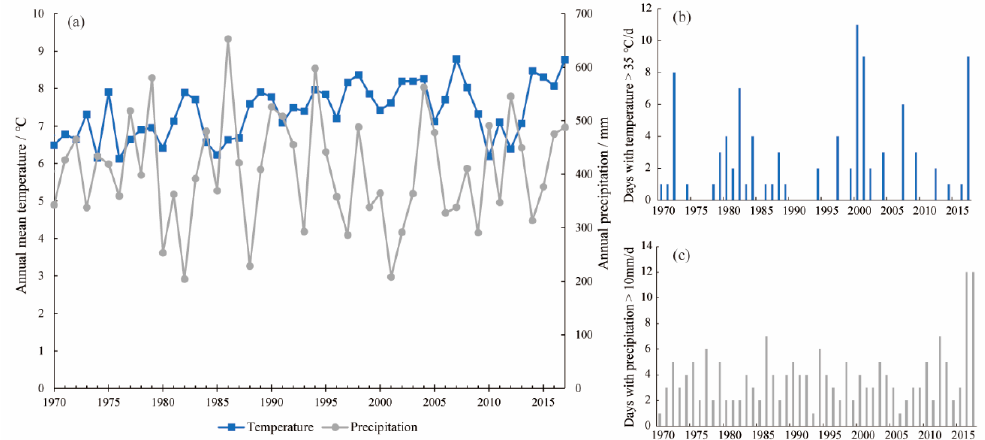
Figure 4. Variation of annual average temperature and annual precipitation ( a ), days with temperature above 35 °C ( b ), days with precipitation above 10 mm ( c ) in Kulun from 1970 to 2017.